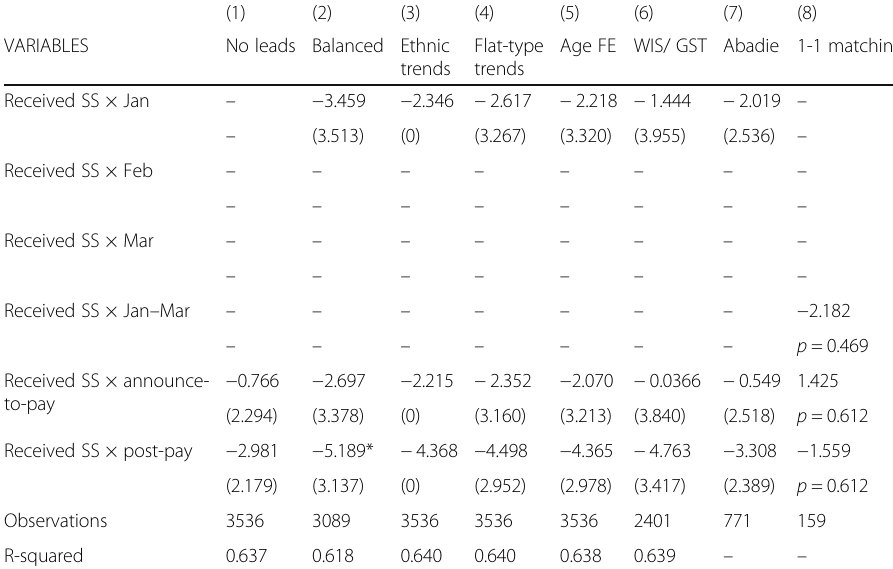
Table 13 Robustness check for impact of receiving SSS payouts on probability of working full-time after age